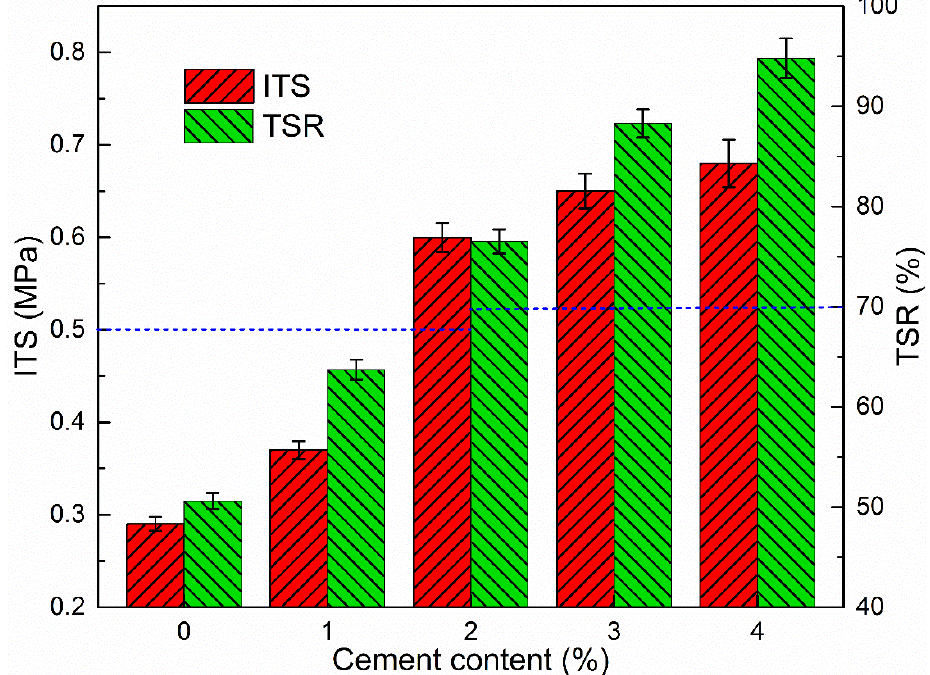
Figure 13. Influence of cement content on ITS and TSR.